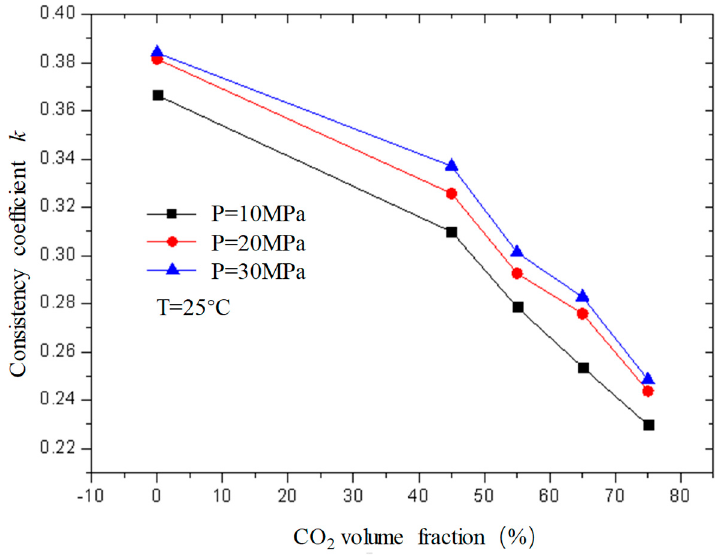
Figure 12. Variation curve of consistency index with CO 2 volume fraction under different pressures (unfoamed).